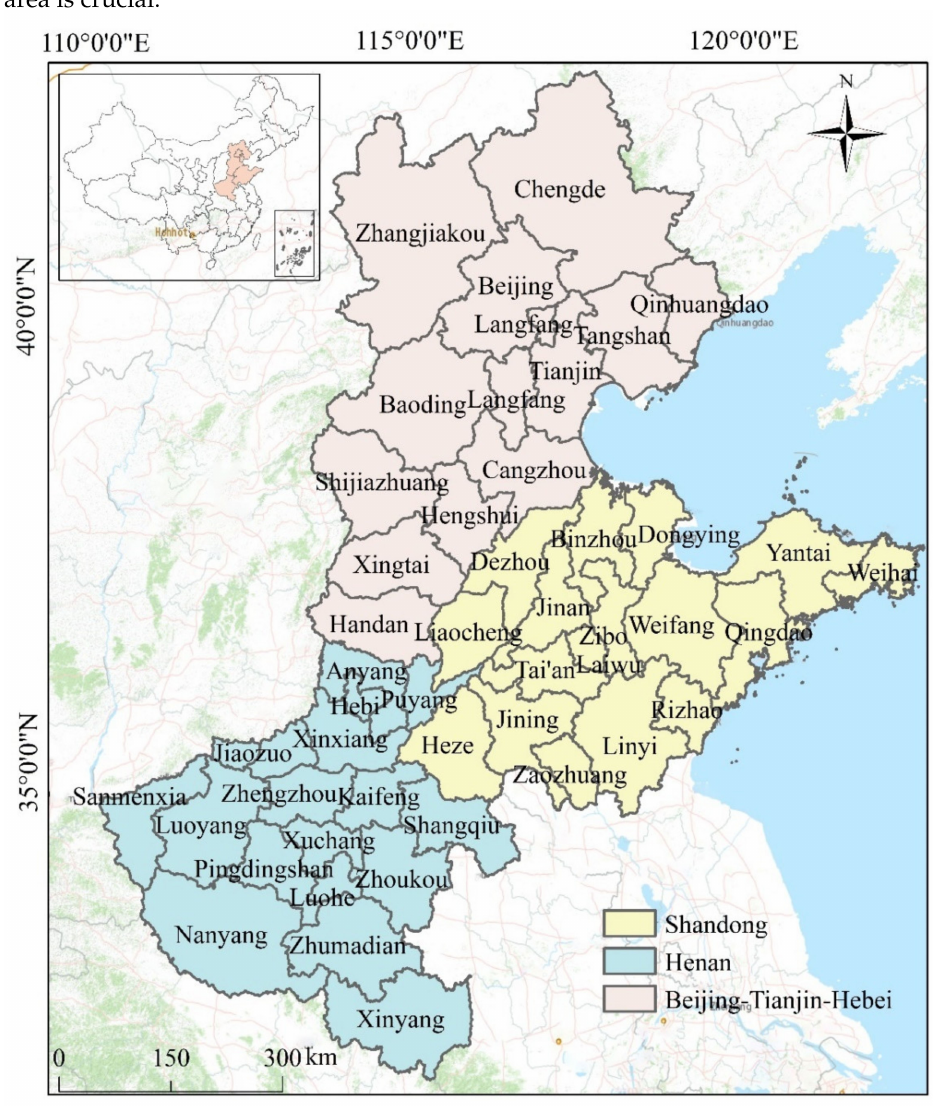
Figure 1. Spatial location of the study